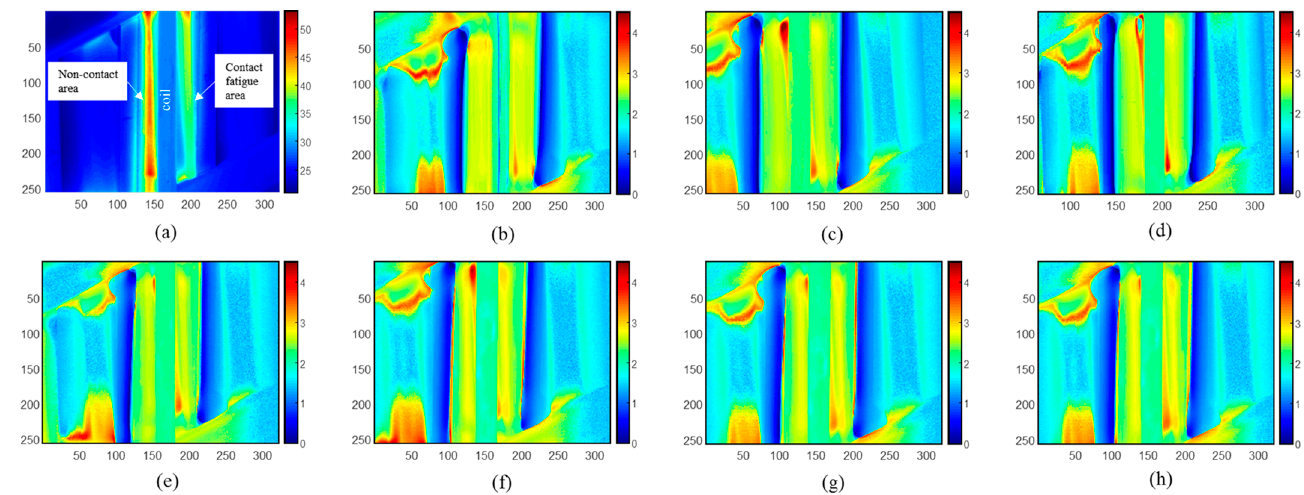
Figure 6. Fatigue evaluation after emissivity correction. ( a ) Raw IR image of stage 3. ( b ) Recon- structed image of stage 0. ( c ) Reconstructed image of stage 1. ( d ) Reconstructed image of stage 2. ( e ) Reconstructed image of stage 3. ( f ) Reconstructed image of stage 4. ( g ) Reconstructed image of stage 5. ( h ) Reconstructed image of stage 6.